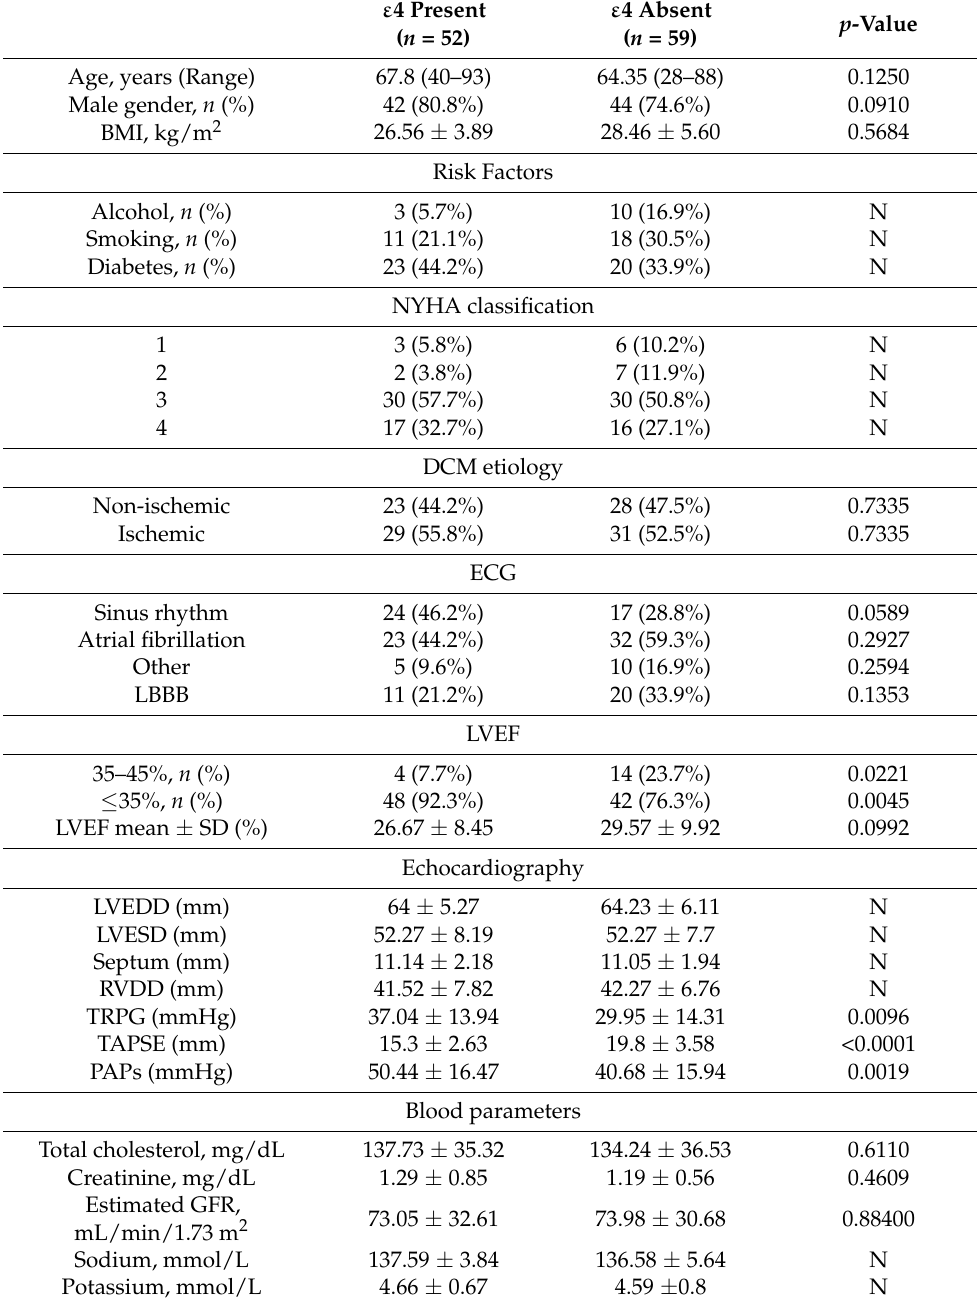
Table 4. The main characteristics of the patient according to ε 4